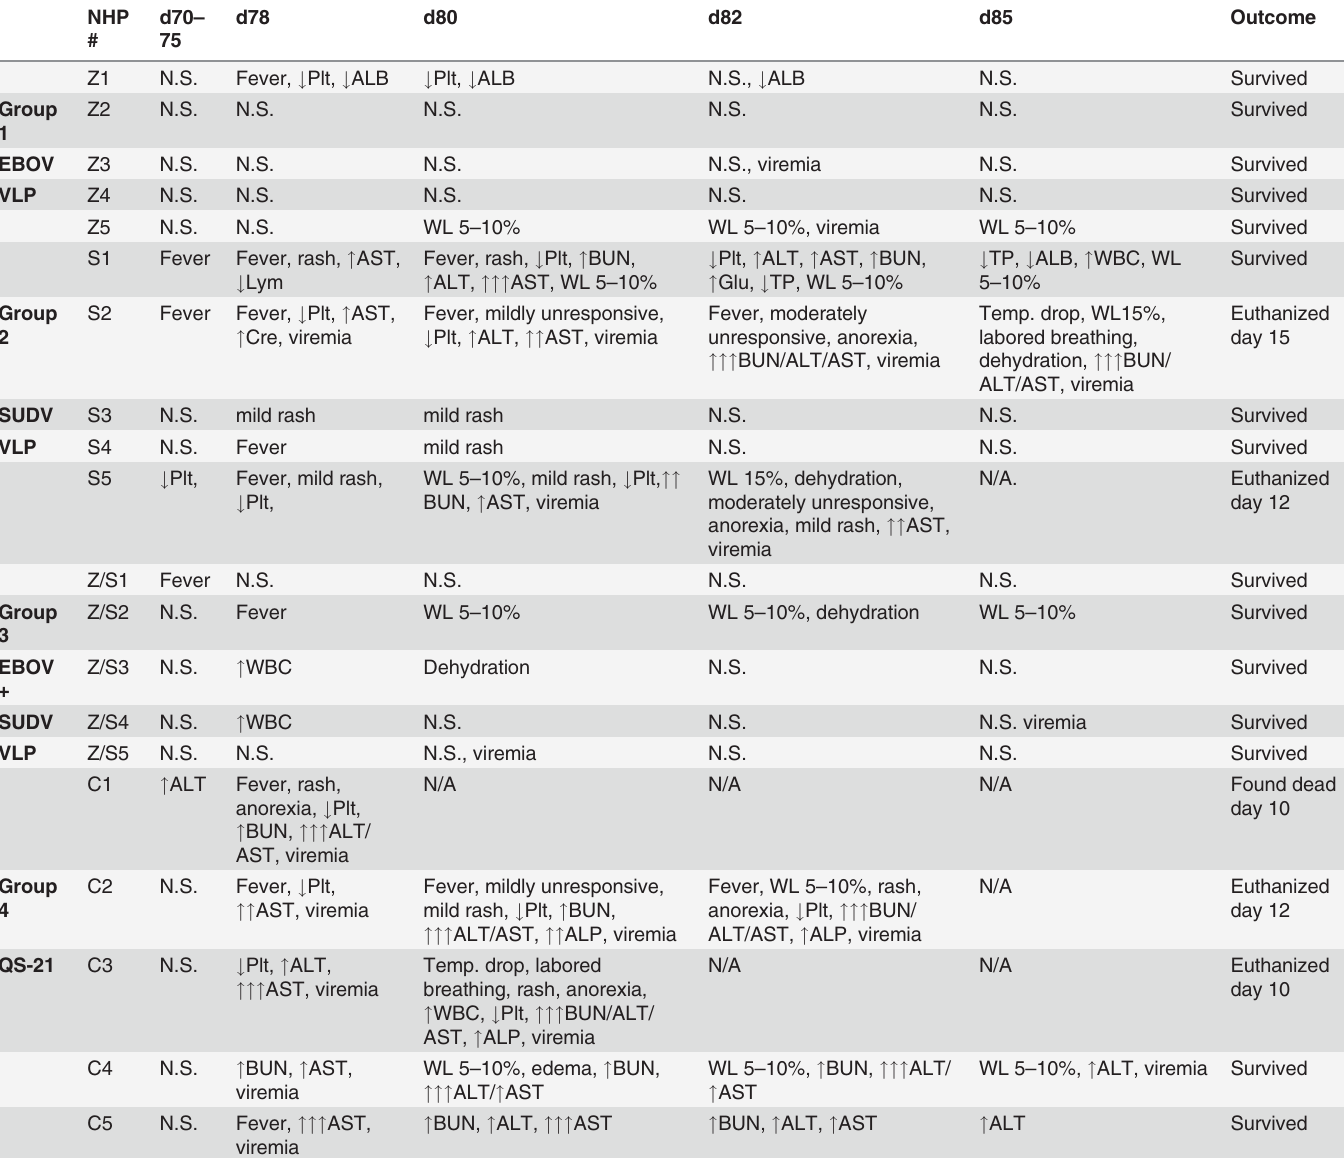
Table 3. Summary of the TAFV challenge study results through 15 days post challenge (study day 70 – 85). NHP